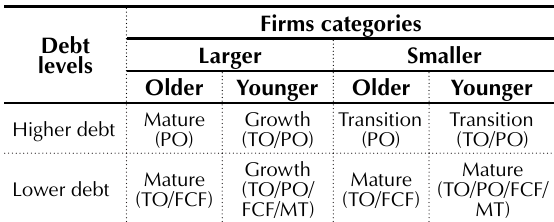
Table 6. Theories